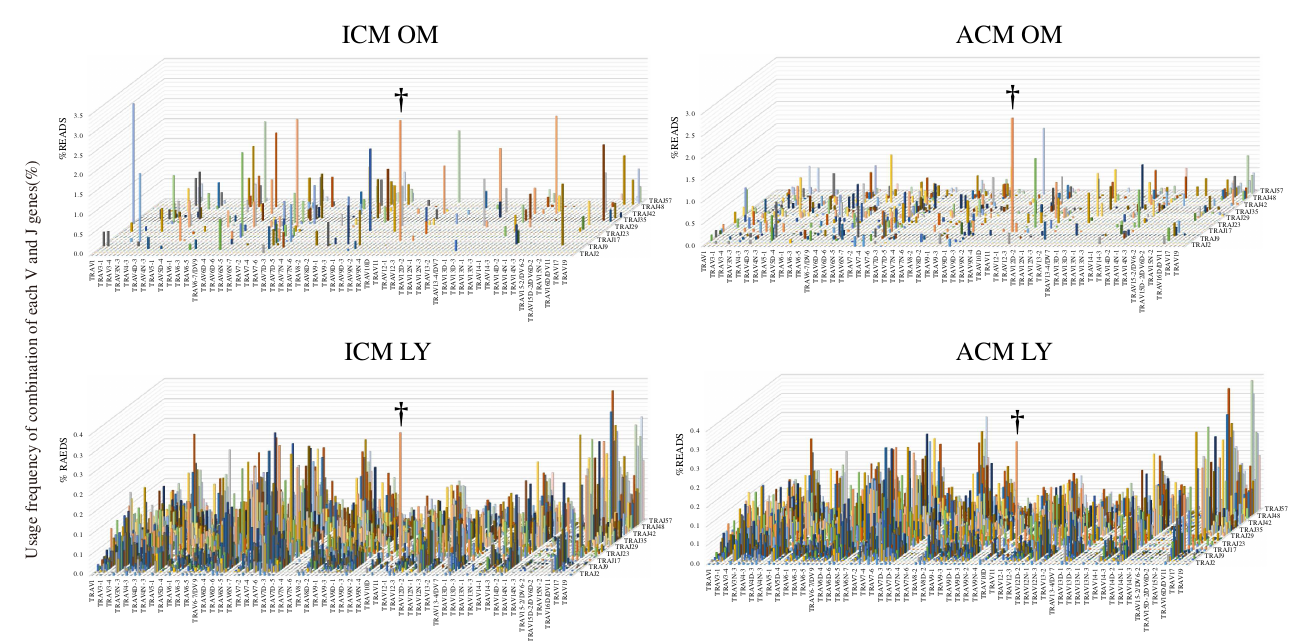
TRAV11d-TRAJ18 was considerably higher in the oral mucosa and cervical lymph nodes of the ICM and ACM mice († in Figure 5).